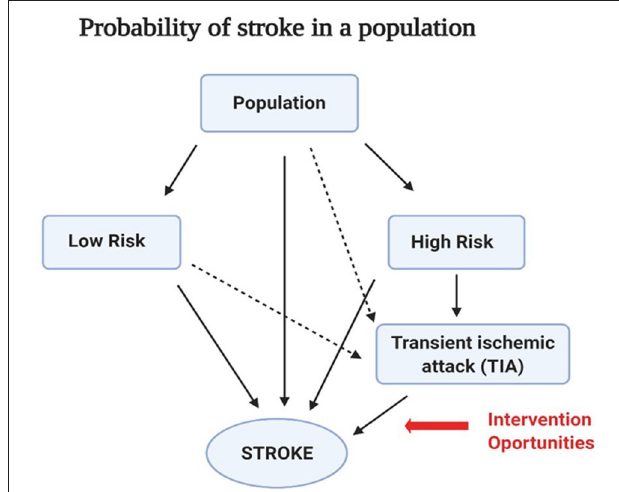
FIGURE 1 | Changing risks of stroke recurrence in a population. Schematic diagram of the risk of stroke recurrence in the general population. There are mainly two groups: those with low risk (without any disease apparently) and those with high risk (people with prior cardiovascular diseases, diabetes, and hypertension). The probability of experiencing a transient ischemic attack (TIA) was higher in the high-risk group than that in the low-risk group. In addition, a TIA event increases the probability of recurrent stroke. Recognition of this risk structure provides a unique opportunity for early health interventions and stroke